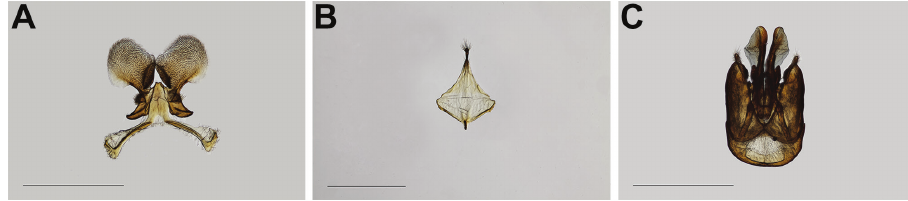
Figure 3. Terminalia of Mourecotelles braziliensis A S7, ventral view B S8, ventral view C genital capsule, dorsal view. Scale bars: 1